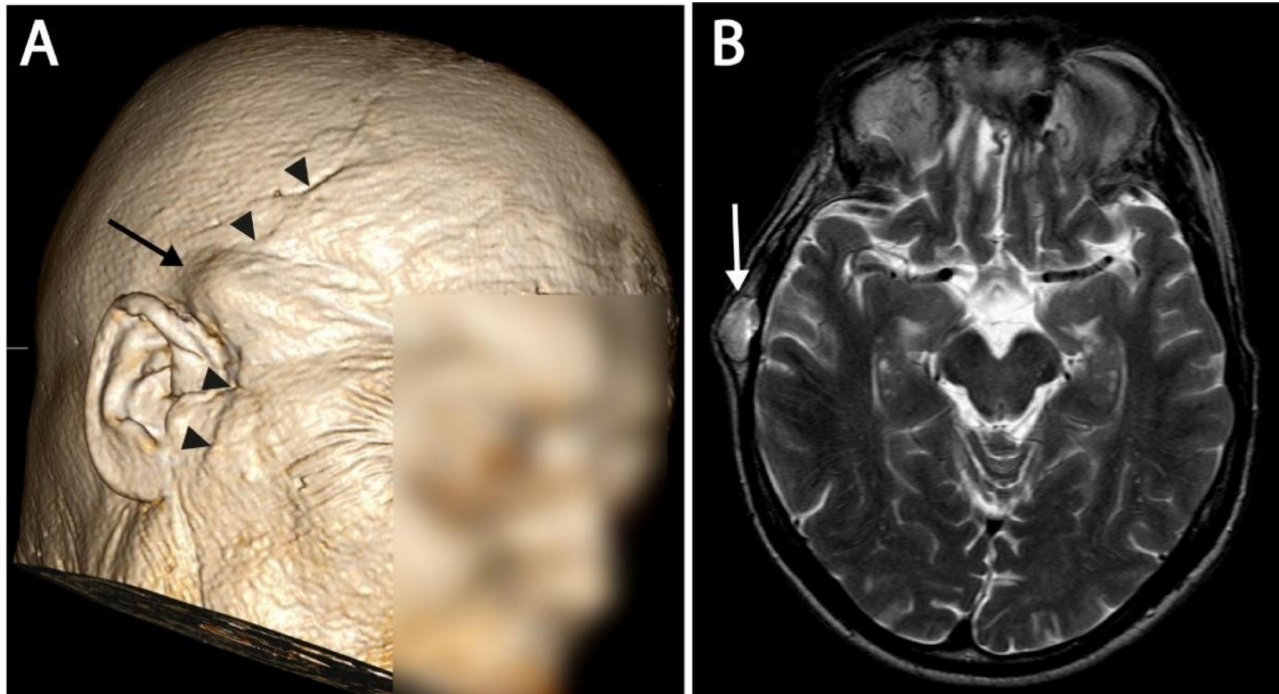
Figure 3. ( A ) 3D reconstructed image of an MRI. A subcutaneous recurrence is visible as a bump under the skin, and is indicated with an arrow. The surgical scar from the coronal midfacial approach is also visible and marked with arrowheads. ( B ) T2 image of the same patient at the level of recurrence. Subcutaneous recurrence is marked with an